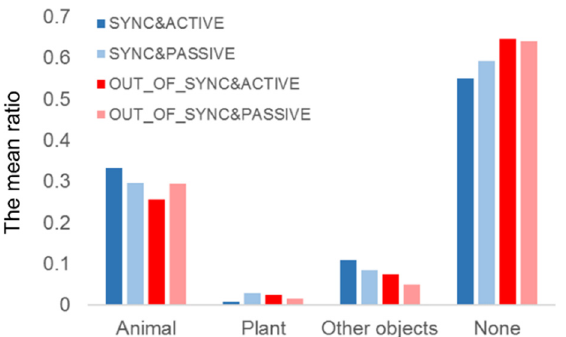
Figure 3. For each condition, the ratio of the categories selected by the participants based on the shapes that they saw within the patterns of random dots (the nine categories were summarized into four: animals, plants, other objects, and nothing).